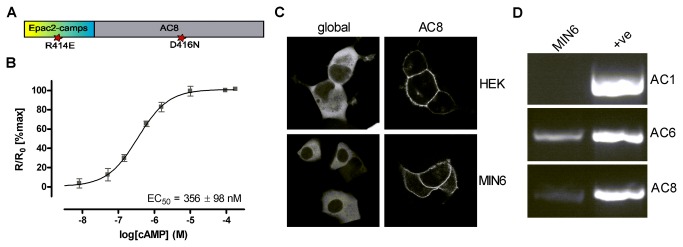
Development of an AC8-targeted sensor for use in MIN6.(A) Cartoon showing the Citrine/Cerulean sensor fused to the N-terminus of AC8 with inactivating mutations in Epac2-camps and AC8 indicated. (B) The cAMP sensitivity of the targeted sensor was determined in
vitro by addition of increasing concentrations of cAMP to crude membranes prepared from HEK293 cells expressing the sensor. EC50 presented as mean±SD (n=4). (C) Confocal images of HEK293 and MIN6 cells expressing the global and AC8 targeted forms of the Ci/Ce sensor. (D) RT-PCR to identify Ca2+-regulated adenylyl cyclases in MIN6 cDNA and in positive control reactions.